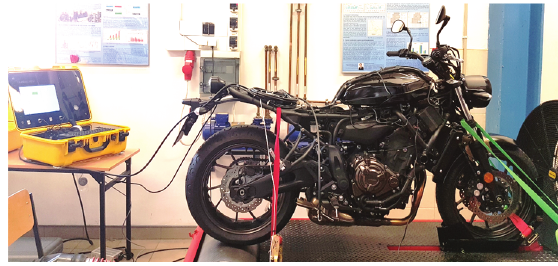
Fig. 6. Picture of the tested motorcycle along with the measuring apparatus on the designated dynamometer